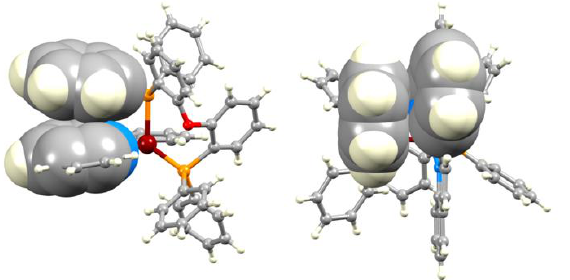
Figure 3. Two views of the face-to-face π-stacking in the [Cu(POP)(bq)] + cation in [Cu(POP)(bq)][BF 2MeOH (CSD refcode JITNIK